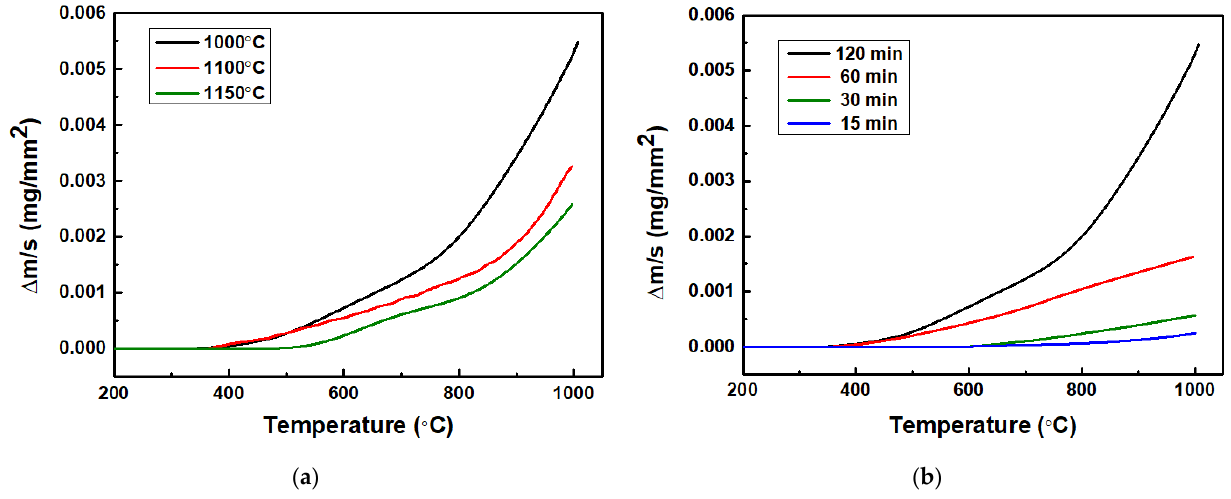
Figure 11. TGA non-isothermal curves of the as-formed CrSi 2 samples synthesized at various ( a ) temperatures and ( b ) times during the chromizing step.